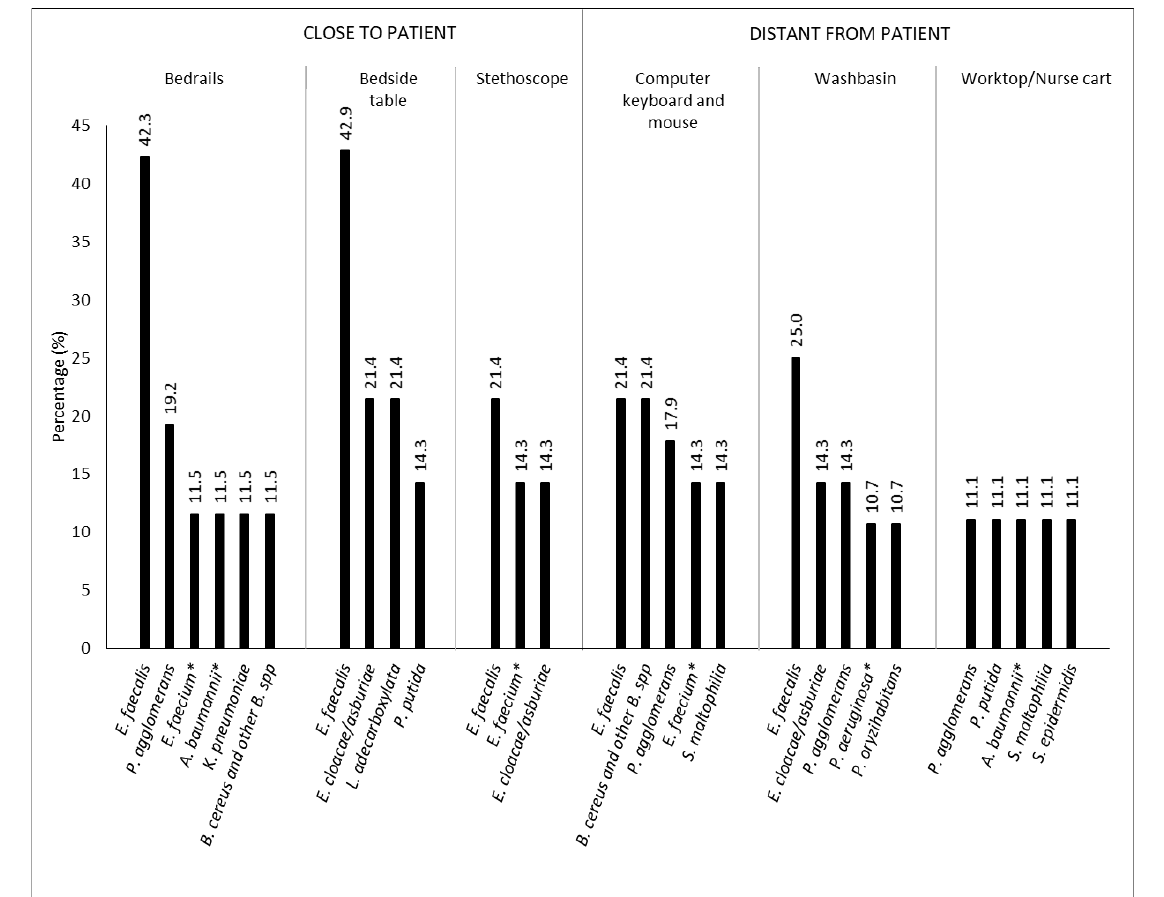
Figure 2. Distribution of bacteria found on room surfaces of ICU#1 and ICU#2, between January 2020 and December 2021 ( n = 223), depending on sampling site. Only occurrences > 10% were shown (*: bacteria of interest).